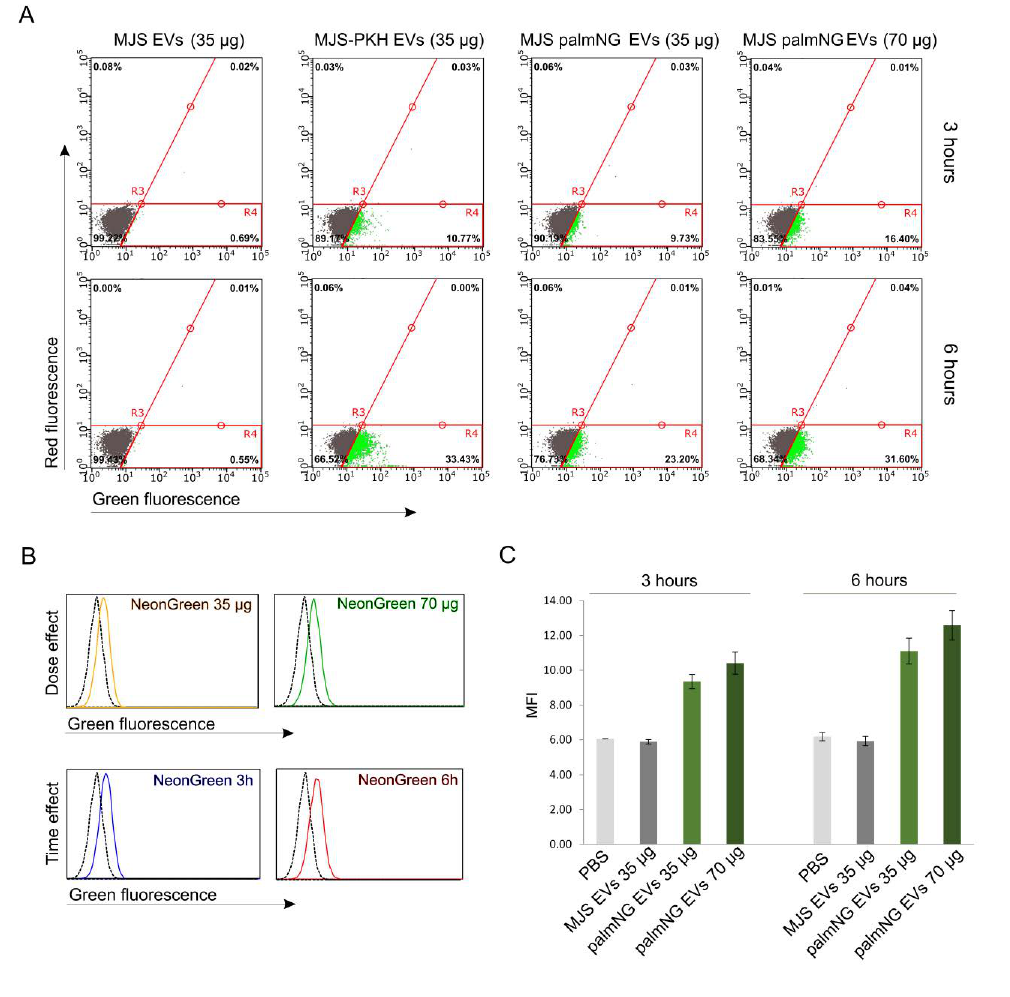
Figure 5. Time- and dose-dependent palmNG-EVs uptake by Huh-7 cells. Huh-7 cells were incubated with MJSpalmNG-derived EVs in a dose range. MJS-derived EVs or MJS-derived EVs stained with PKH67 were used as controls. After the indicated time points, the cells were collected and analyzed using flow cytometry in order to assess the EVs uptake. ( A ) Green fluorescence-positive cells were gated as the green cell population. ( B ) Representative histograms show a dose-dependent and time-dependent shift in the GFP fluorescence of the internalizing cells. The black lines represent MJS-derived EVs; the colored lines represent palmNG EVs. ( C ) The mean fluorescence intensities (MFI) of the internalized EVs from a duplicate analysis are represented as bars with standard